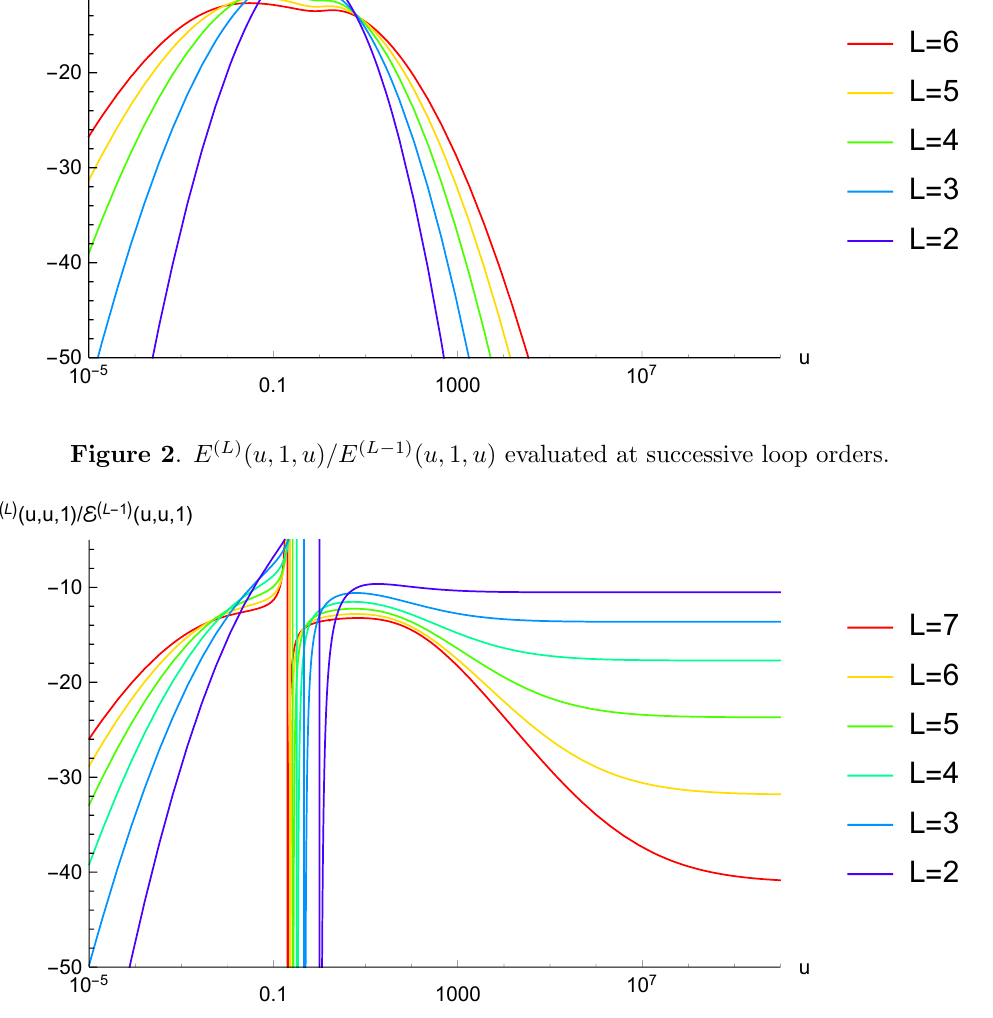
Figure 3 . E ( L ) ( u; u; 1) = E ( L (cid:0) 1) ( u; u; 1) evaluated at successive loop orders. As there are